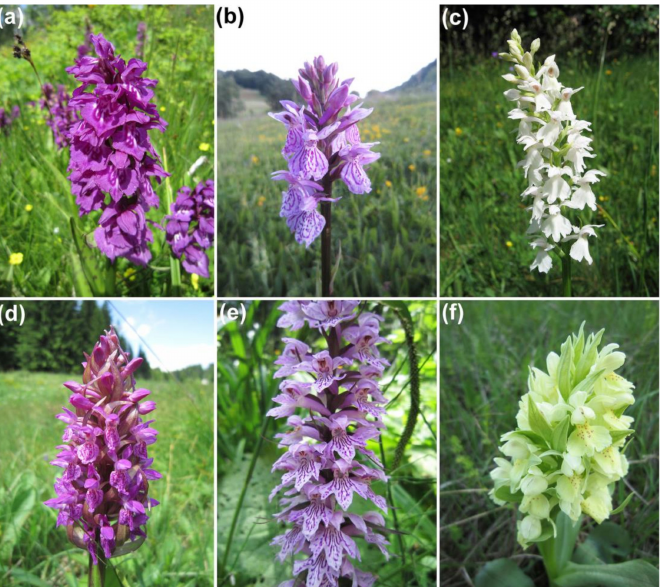
Figure 1. Some representatives of the genus Dactylorhiza of wetland vegetation in the Central Balkans: ( a ) Dactylorhiza cordigera subsp. cordigera , ( b ) Dactylorhiza maculata subsp. maculata , ( c ) Dactylorhiza maculata subsp. transsilvanica , ( d ) Dactylorhiza incarnata subsp. incarnata , ( e ) Dactylorhiza saccifera subsp. saccifera , ( f ) Dactylorhiza sambucina (photos V. Djordjevi´c).